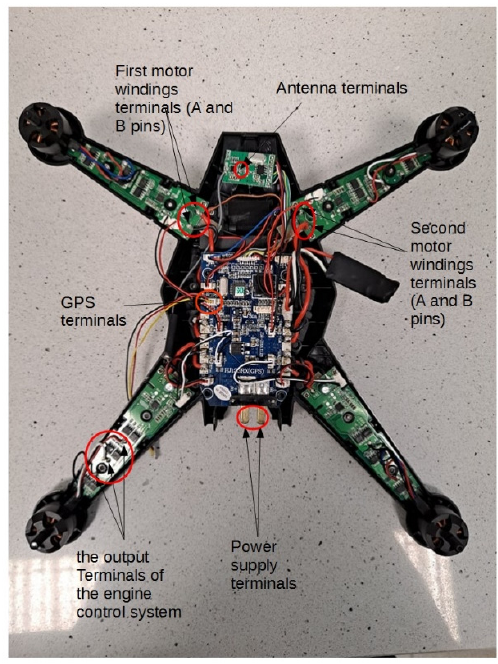
Figure 6. Tested drone electronic systems.